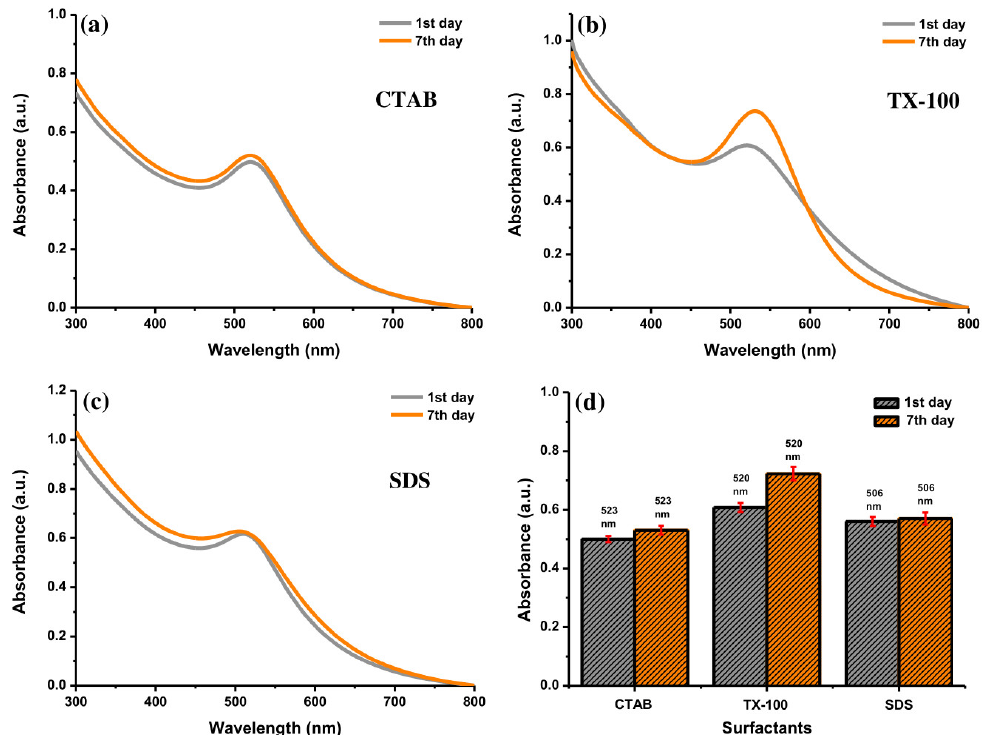
Figure 9. The UV-Vis absorption spectra of Au NPs with ( a ) CTAB, ( b ) TX-100, and ( c ) SDS after preparation and after storing for 7 days, and ( d ) their comparison at specific absorption peak of Au NPs with different surfactants. Conditions: surfactant concentration = 10 mM, laser fluence = 0.4 J cm −2 , and ablation time = 40 min.